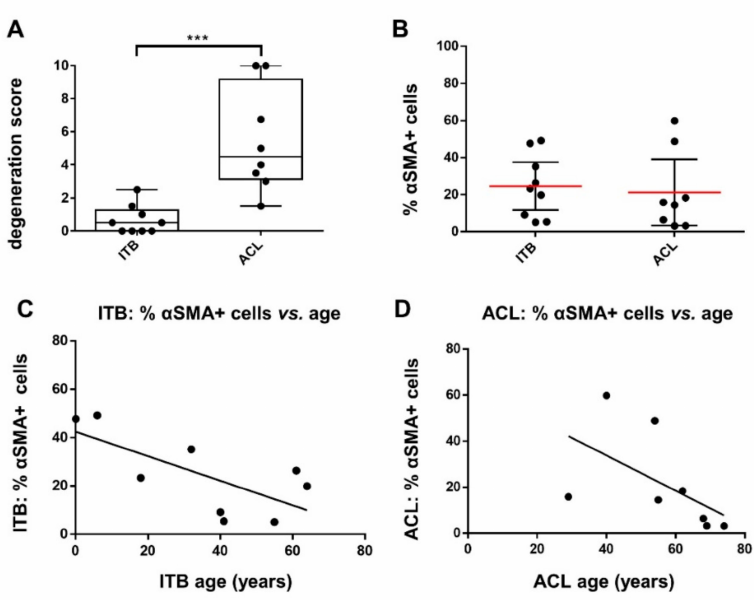
Figure 3. The degree of degeneration and the percentage of α SMA-positive cells as well as age vs. percentage of α SMA-positive cells in ITB and ACL. ( A ) The di ff erences in the degeneration scoring results and ( B ) the percentage of α SMA-positive cells. The correlation between the percentage of α SMA-positive cells in ITB ( C ) and ACL tissue samples ( D ) and donor age. Figure 1A: *** p = 0.0002, Mann–Whitney test; Figure 1B: no significant di ff erence; Figure 1C: significant negative correlation ( p = 0.035), pearson, r = − 0.703; ( D ): not significant, pearson, r = − 0.552, p = 0.156.